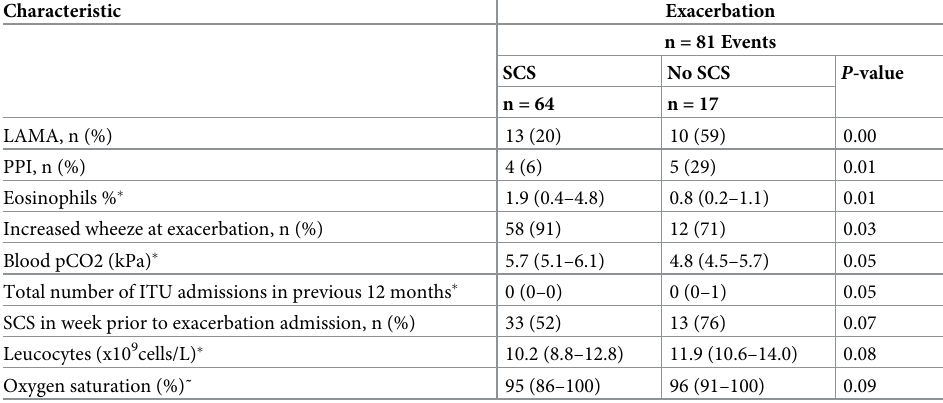
Table 3. Comparison of D0 exacerbation characteristics of patients given SCS versus patients not given SCS for which p < 0.1 (see S1 Appendix for all other characteristics evaluated).